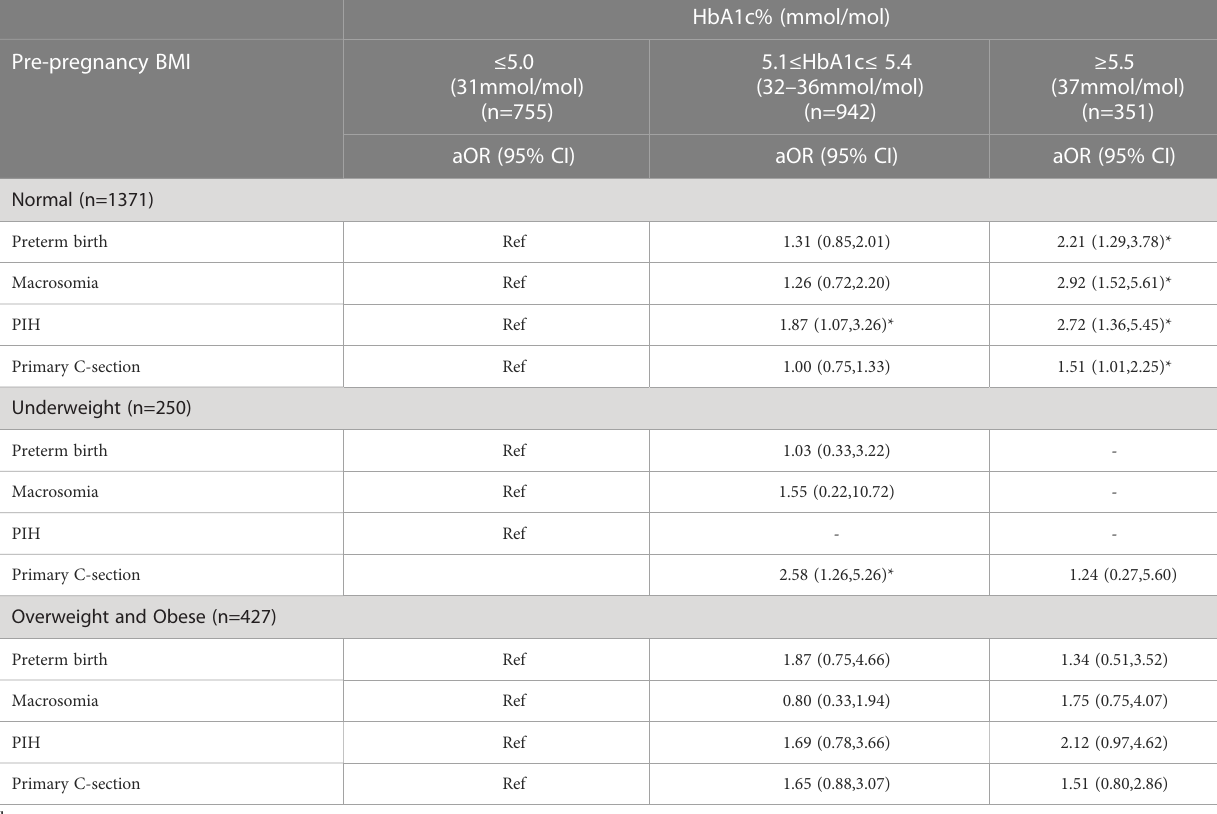
TABLE 4 Association between HbA1c and adverse outcomes in different pre-pregnancy BMI